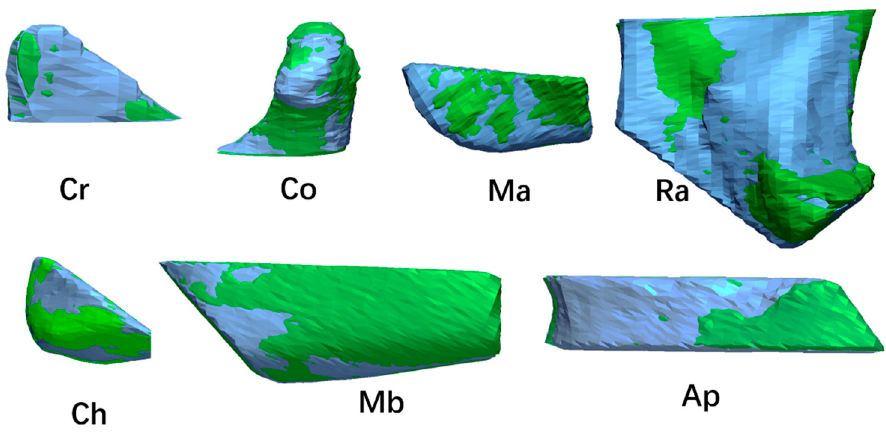
Figure 5. Best-fit alignment of the mandibular units. Original mandibular units models (blue) and the mirrored units models (green).